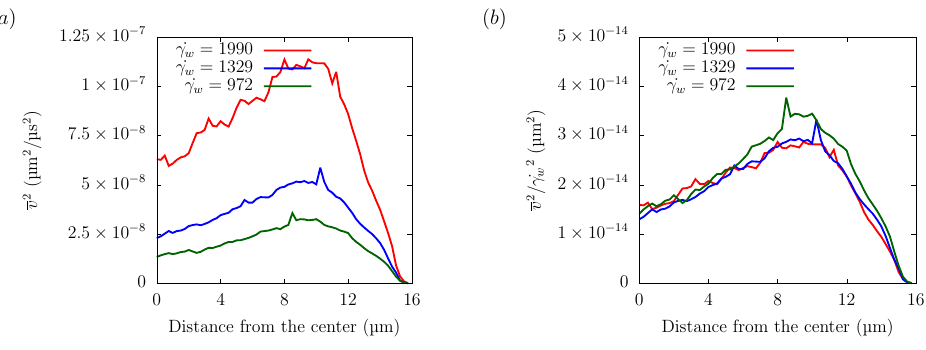
Figure 14. Velocity fluctuation in the z = 16 µ m plane. ( a ) Velocity fluctuation time-averaged and spatially averaged velocity components ˙ γ w = 972 s − 1 , 1329 s − 1 , and 1990 s − 1 . ( b ) Velocity fluctuation normalized by the wall shear rate ˙ γ w